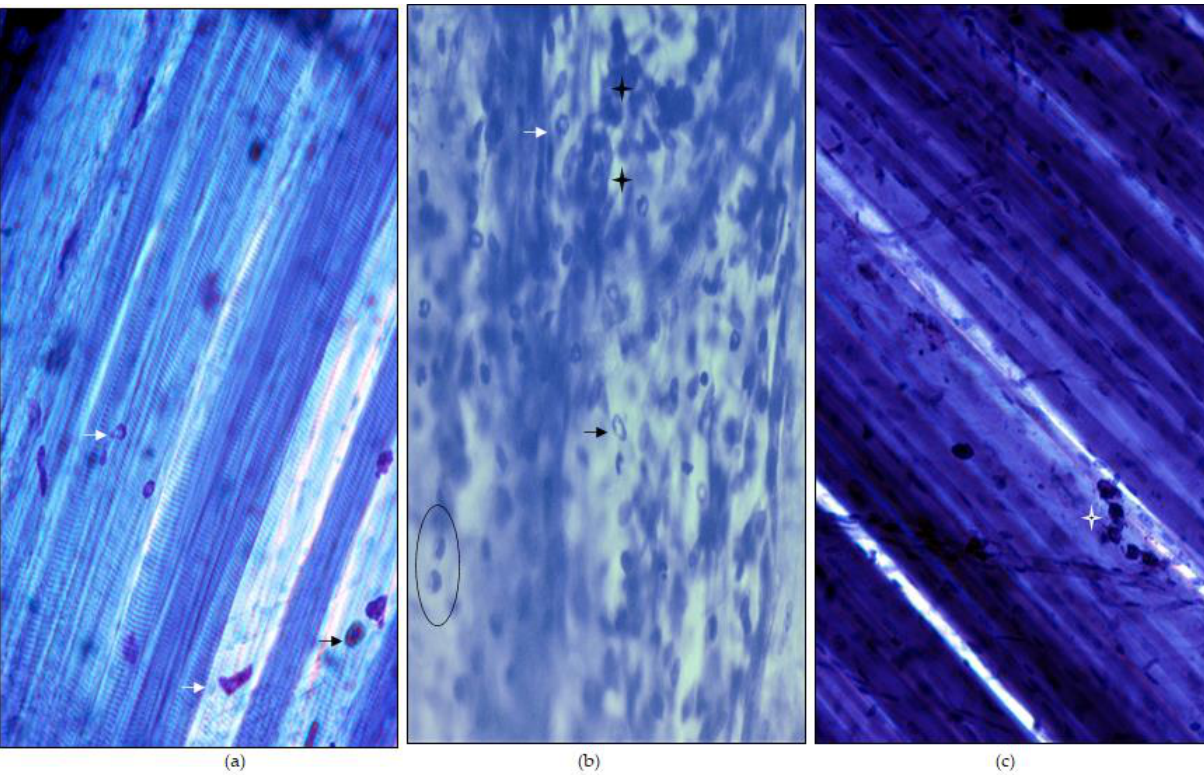
Figure 2. Muscular injury. The samples (LAL) were stained with methylene blue. ( a ) Normal image of the LAL muscle stained with methylene blue. The muscle fibers can be clearly distinguished. Some mast cells (arrow heads) are also commonly seen. Mast cell granules stain better than nuclei and a clear central part is present. ( b ) Bupivacaine provokes a very clear muscle lesion that is visible at 72 h. Muscle fibers cannot be seen because they are degenerated. In addition to mast cells (arrowheads), there are areas with abundant inflammatory cells (stars). Macrophages are easily identifiable (within a black circle). ( c ) After 7 days of exposing the muscle to bupivacaine, a fully regenerated muscle can be seen. The muscle fibers can be clearly seen again. Some residual inflammatory cells (star) can be seen. Initial magnification, 100 ×